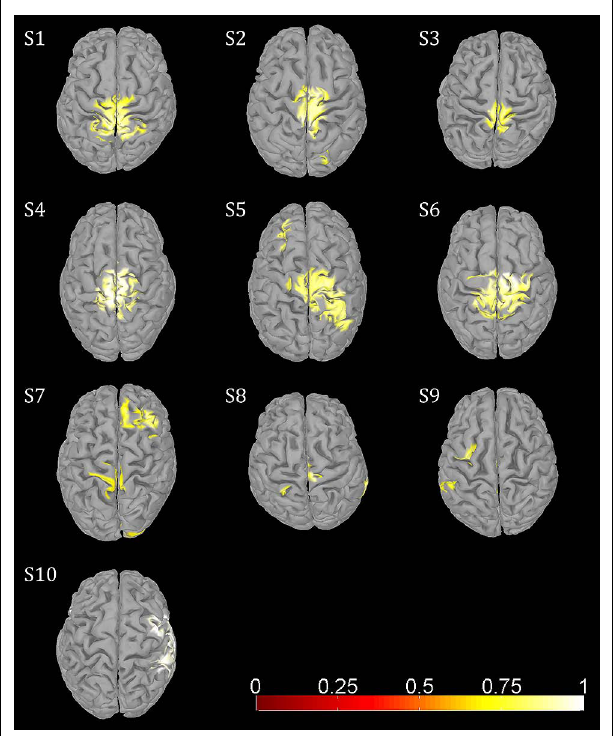
FIGURE 4 | Functional topographies of significant (non-parametric permutation tests, corrected FWER < 0.05) gait phase modulated oscillations (GPM) at individual GPM center frequencies (Table